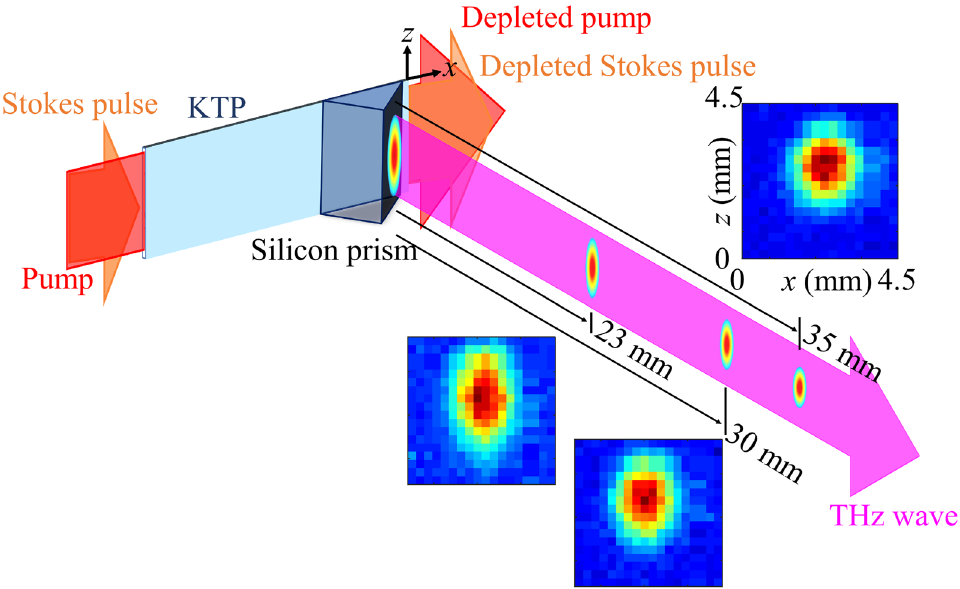
Figure 3. Scanning images of the 5.7-THz beam profile at 23, 30, 35 mm from the output of the silicon prism. The scanning step or the pixel size for the images is 250 μm. The THz beam is collimated in x and focused in z before the 35-mm